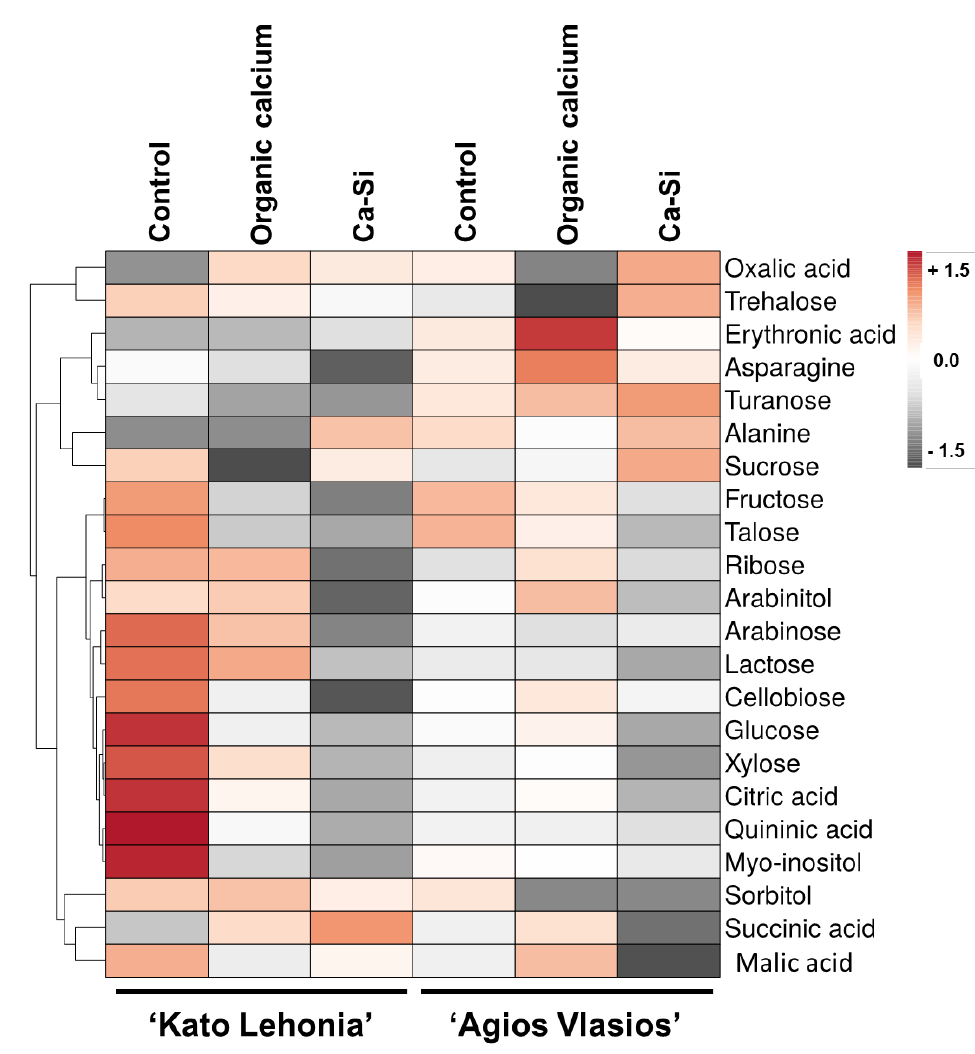
Figure 1. Heatmap diagram of the primary polar metabolite levels in the untreated (control) and in fruit treated with organic calcium and Ca–Si nanoparticles, at the Kato Lehonia and Agios Vlasios orchards in 2019. Each value represents the mean of the relative abundance of adonitol (100 μg mL − 1 ).